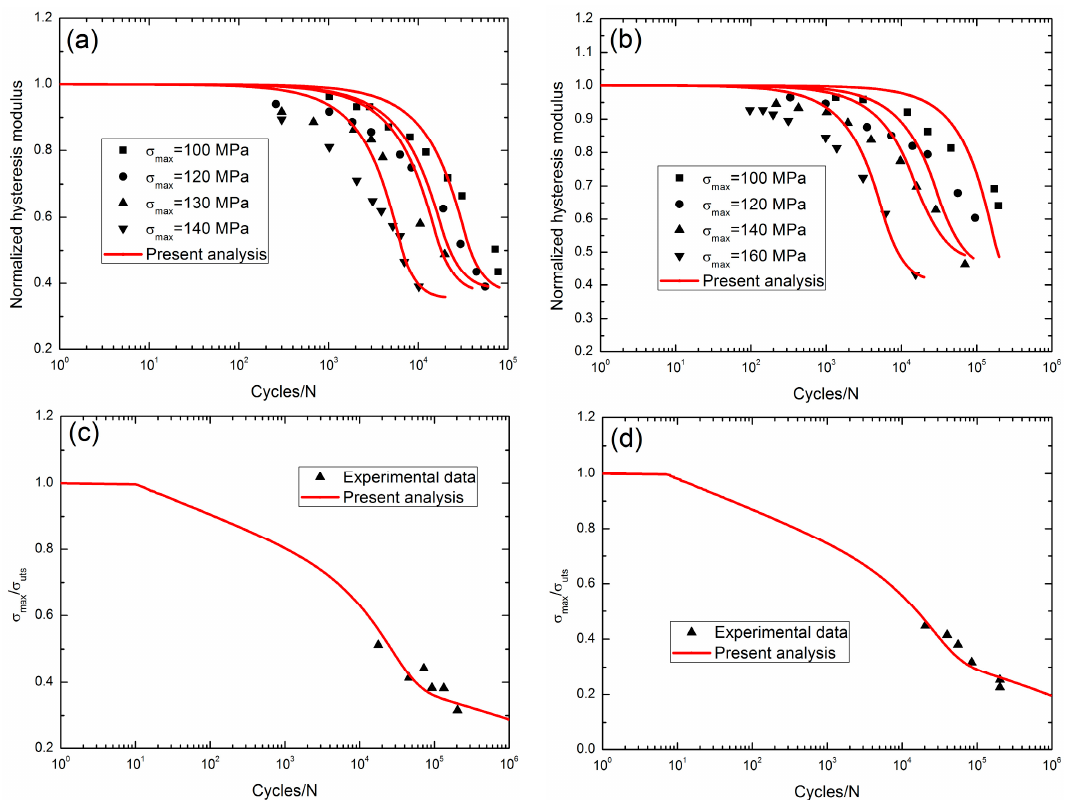
Figure 8. ( a ) The normalized fatigue hysteresis modulus versus applied cycles with the test environment in air; ( b ) the normalized fatigue hysteresis modulus versus applied cycles with test environment in steam; and ( c ) the fatigue life S-N curve with the test environment in air; and ( d ) the fatigue life S-N curve with the environment in steam of 2D SiC/SiC composite at 1300 °C [6]. Table 1. The parameters of the interface shear stress degradation model for 2D SiC/SiC composite under different peak stresses, loading frequencies and test